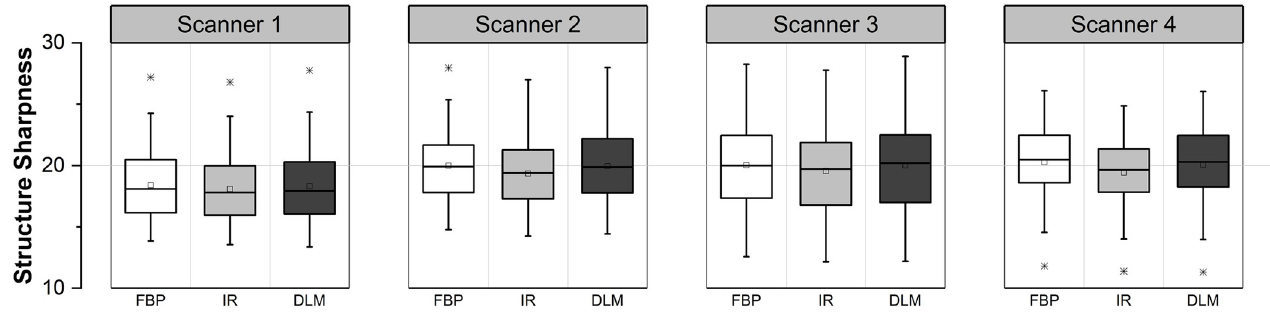
Fig 10. Box plots compare the structure sharpness index across multi-vendor and multi-reconstruction images.